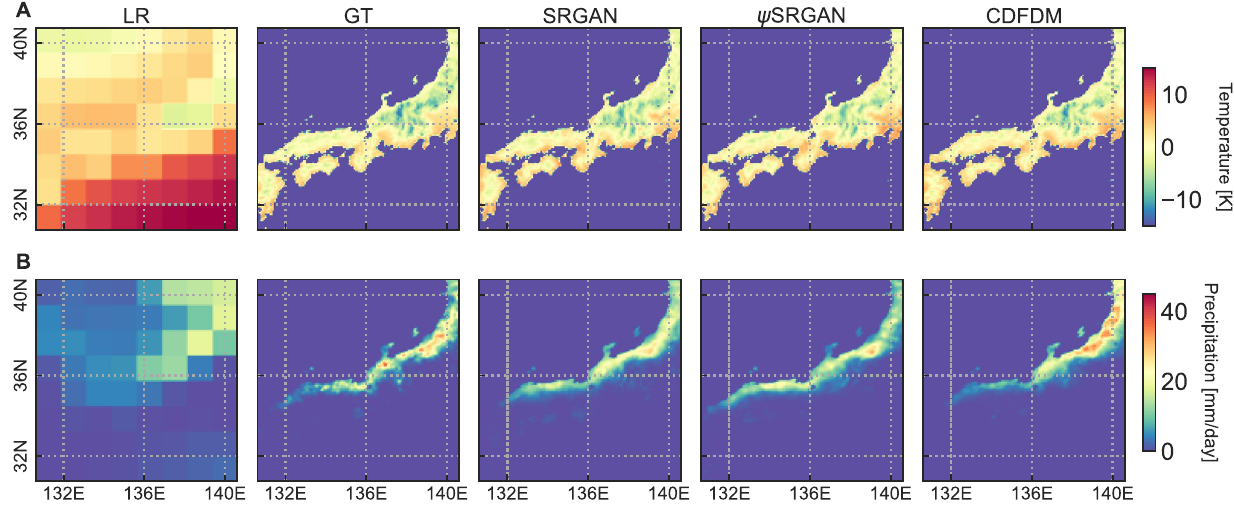
Figure 2. Downscaling results. Distributions of temperature ( A ) and precipitation ( B ) obtained with SRGAN, ψ SRGAN, and CDFDM are compared with the corresponding low-resolution ( 8 × 8 ) inputs (LR) and the high- resolution ( 400 × 400 ) ground truth (GT). The resolution of the downscaled images is the same as that of the GT. The data from January 24, 2008, are